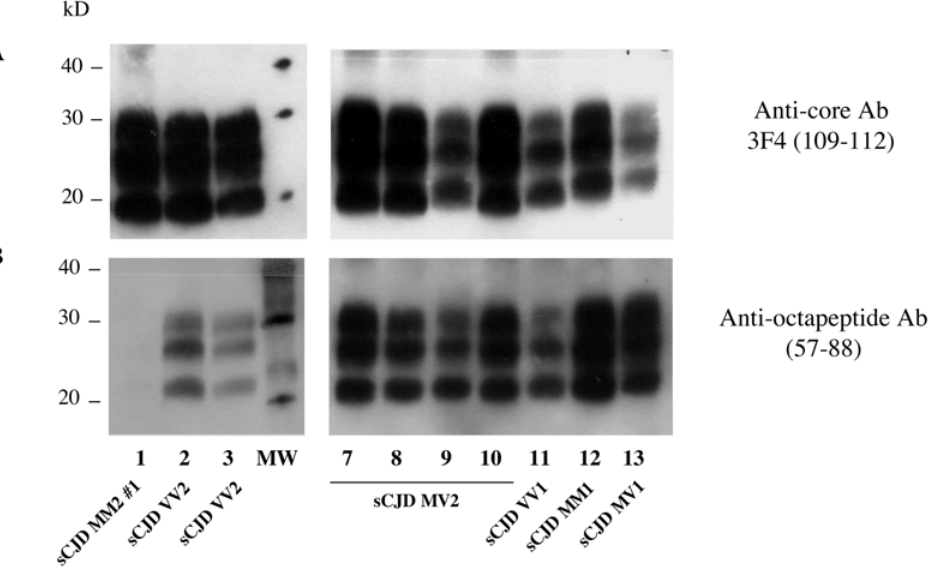
Figure 4. Electrophoretic analysis and differential sensitivity to proteolysis of PrPres in different subtypes of CJD. PrPres from human brain homogenates (MM1, MV1, VV1, MM2, MV2 or VV2 subtypes of sCJD, and vCJD) were purified under high concentrations of proteinase K, and detected with monoclonal antibodies that recognize either the core (3F4, Panel A) or the octapeptide region (Panel B) of the protein. The proportion of PrPres with an intact octarepeat region after PK exposure in VV2 and human (or macaque) vCJD was estimated to be only one-tenth and one- twentieth as high as in an MM1 sub-type of sCJD, respectively.